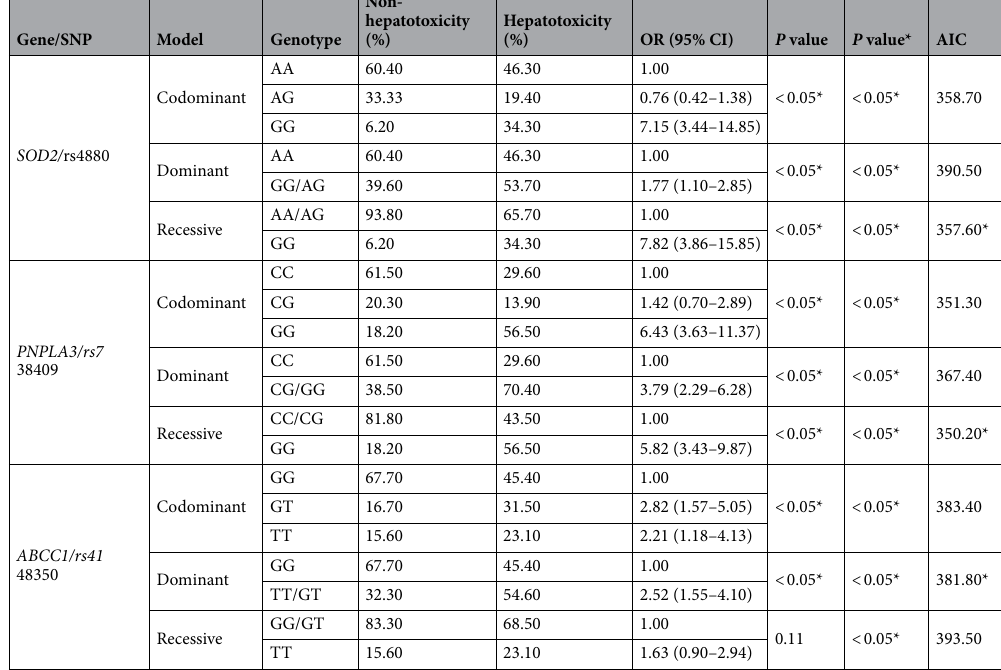
Table 1. Genetic contrast model for hepatotoxicity in ALL patients. P value* (Bonferroni corrected) < 0.05 was considered